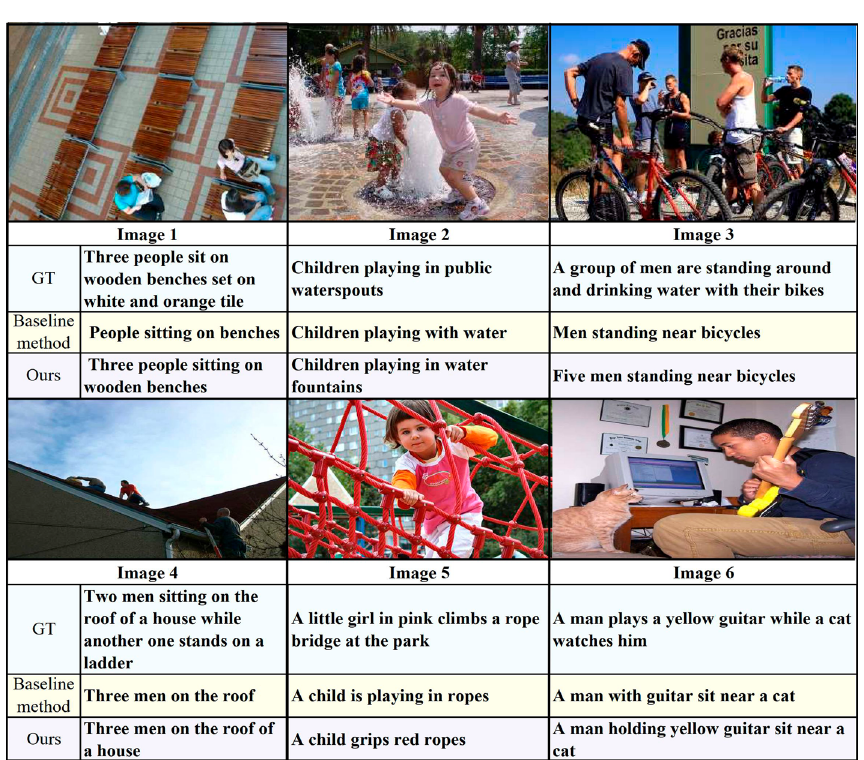
Fig. 3 Comparison of the captions generated by the baseline approach and the proposed method for few samples images. Here GT represents the ground truth